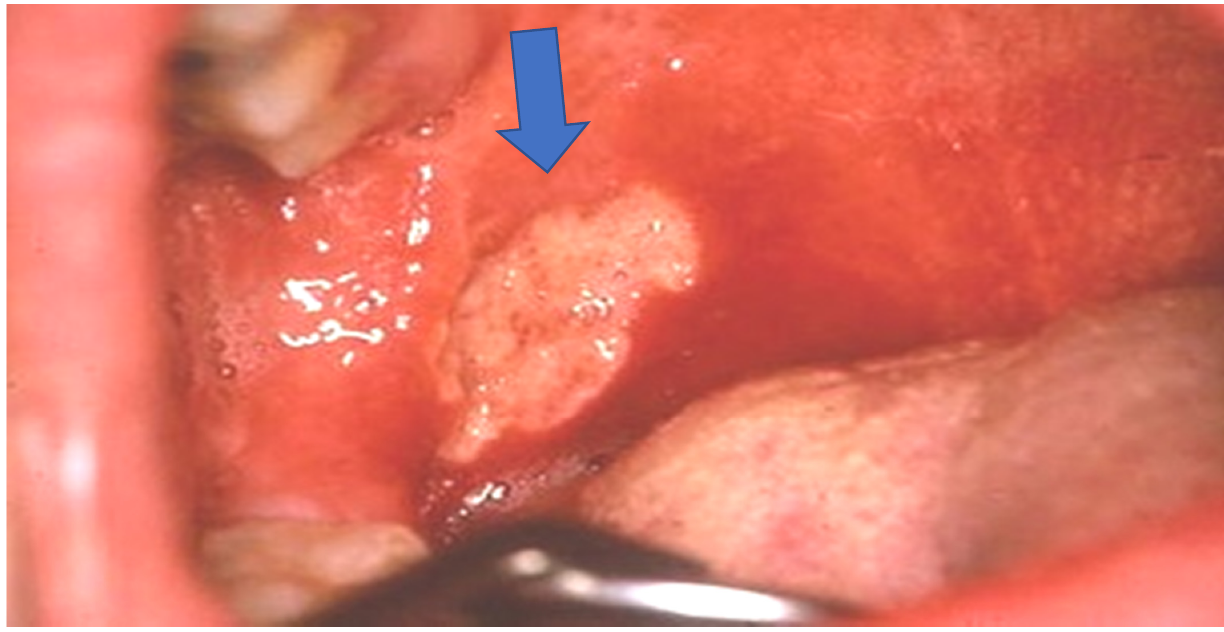
Figure 3. Oral ulcer (blue arrow).